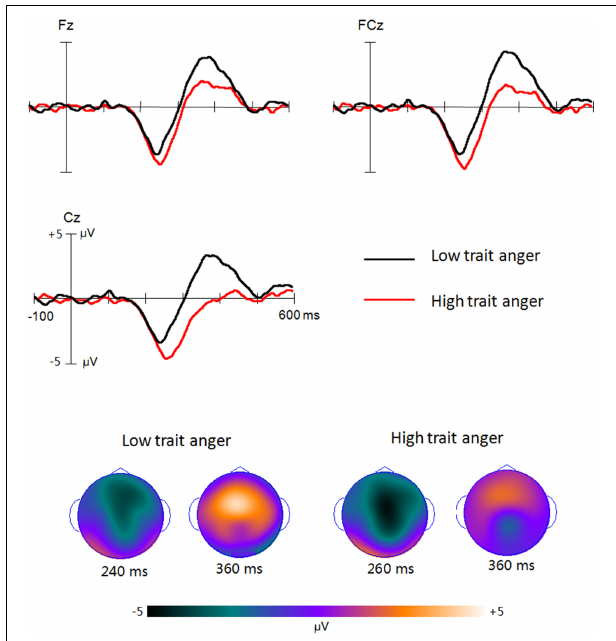
FIGURE 2 | The difference waveforms between Nogo and Go ERPs in low and high trait anger groups, respectively, as well as the 2D scalp distribution topography of the peak amplitudes of N2 and P3